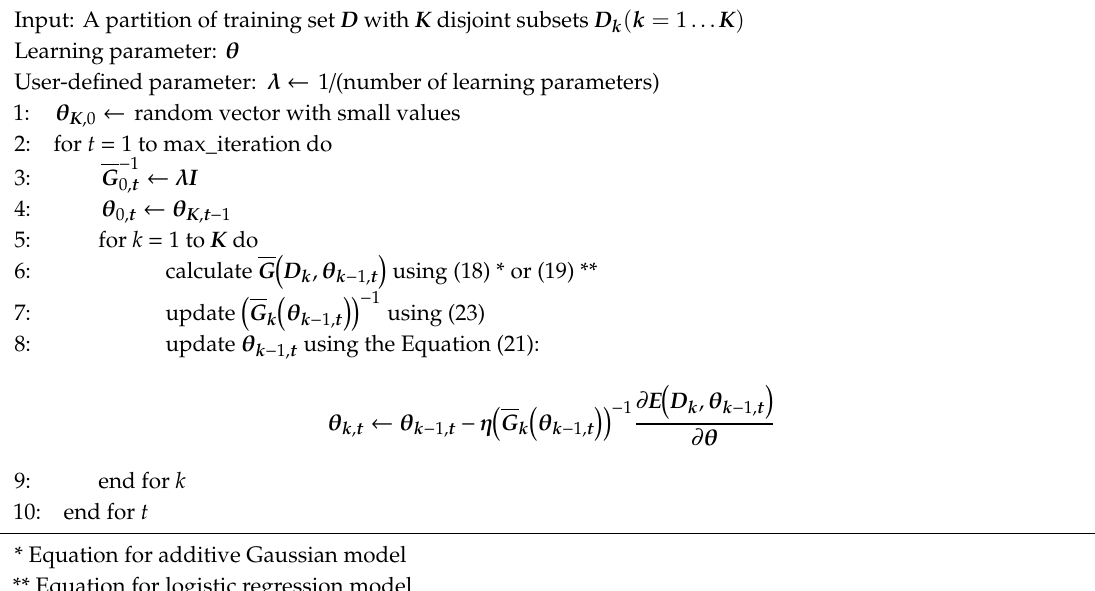
Algorithm 1. Adaptive natural gradient (ANG) for mini-batch learning